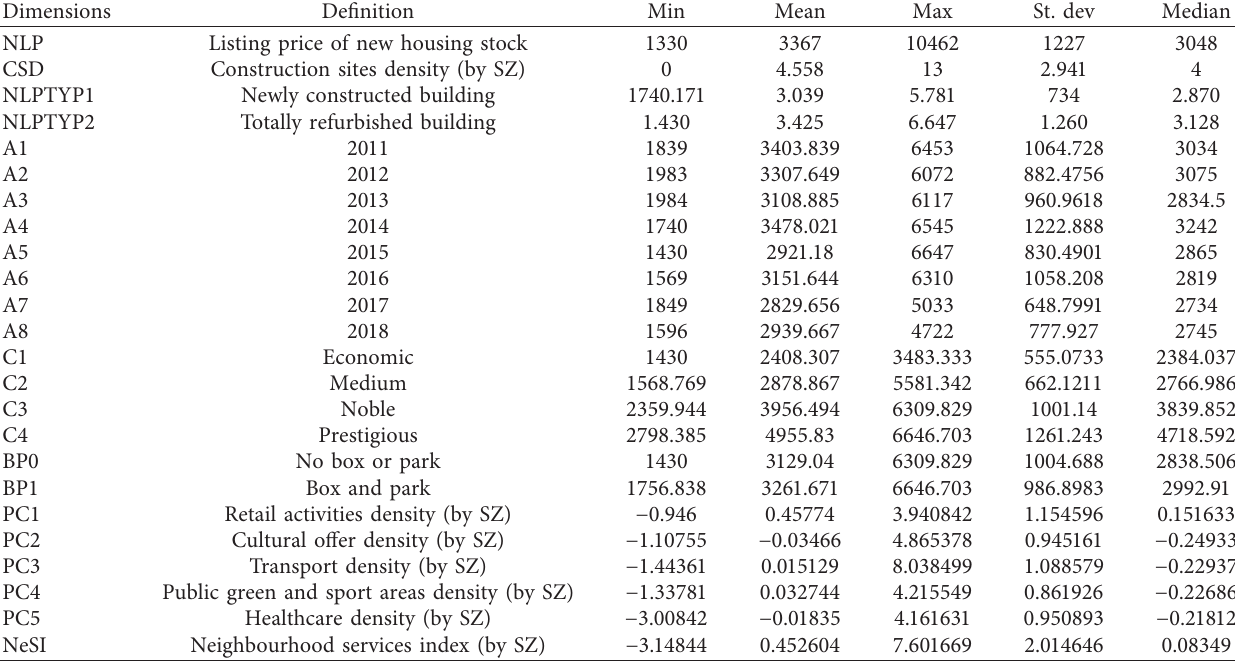
Table 1: Summary statistics of the housing prices and neighbourhood service variables (source: author’s elaboration on TREMO data).